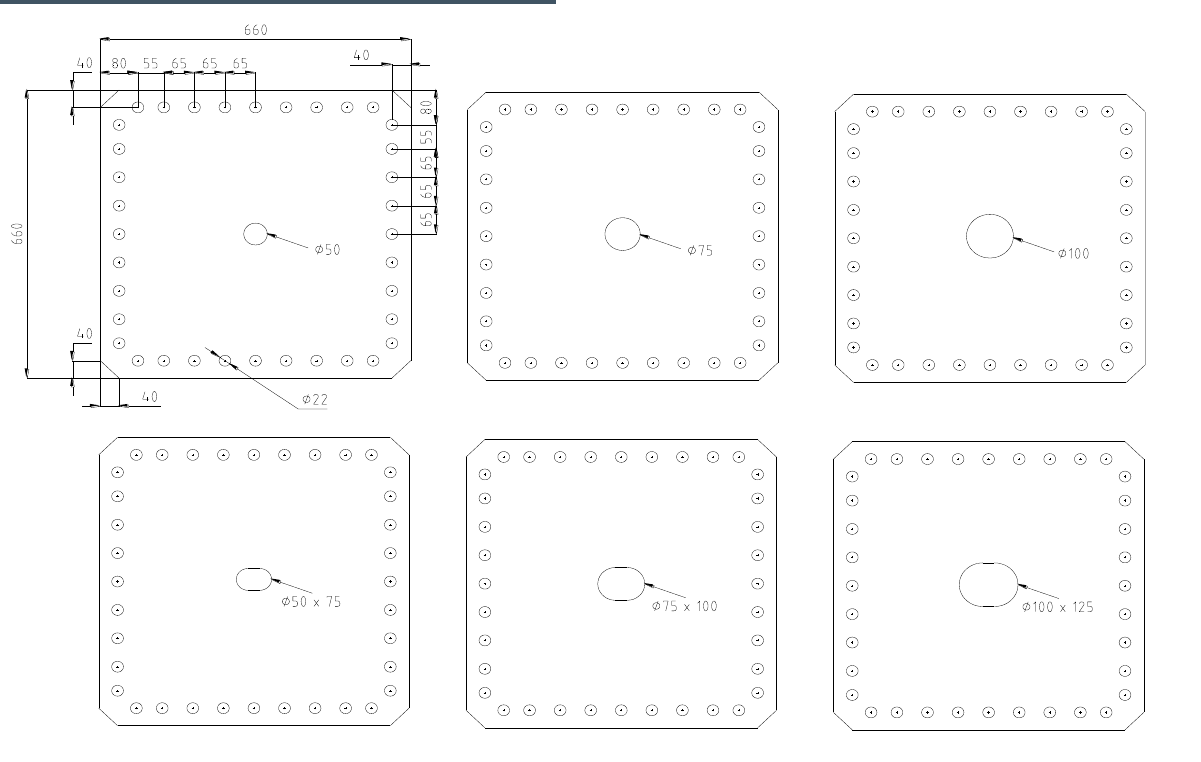
Figure 6. Square plate specimens with circular holes.